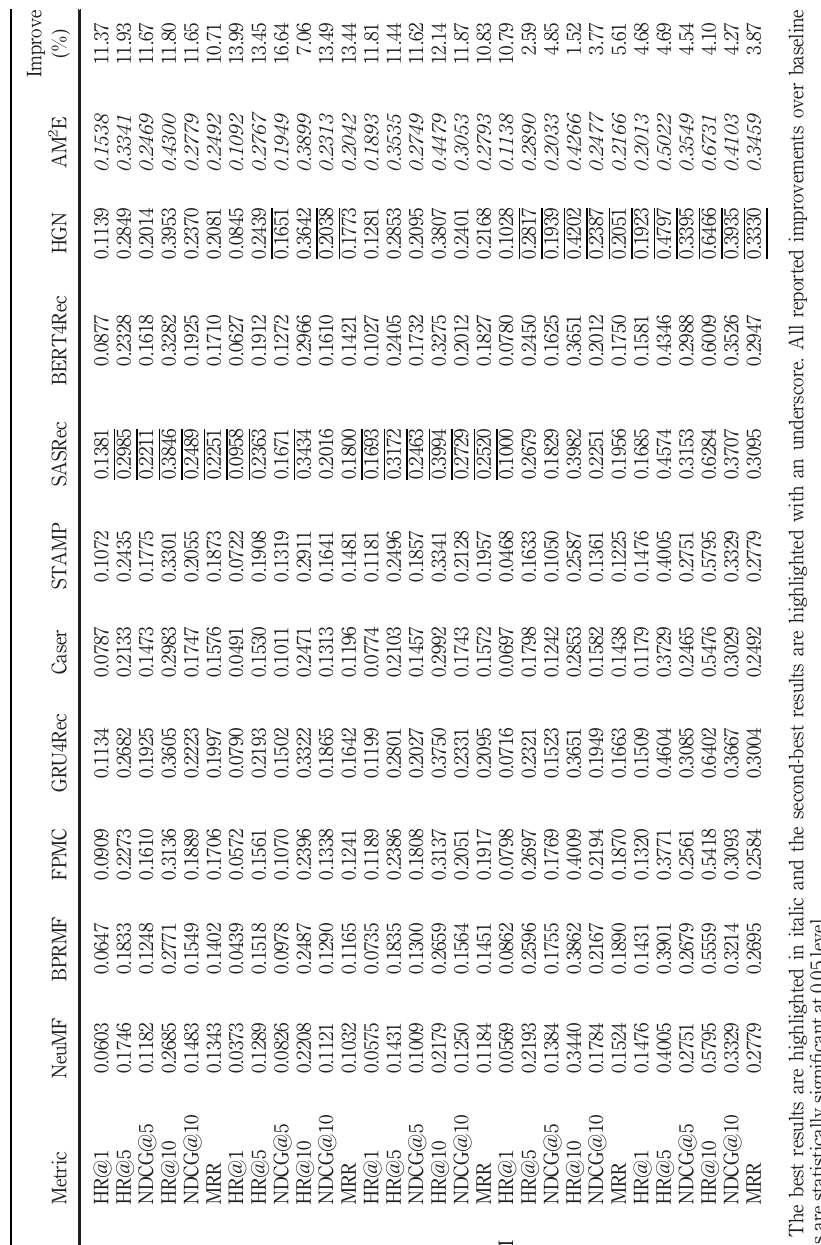
Table 2. Performance comparison with baselines on all data